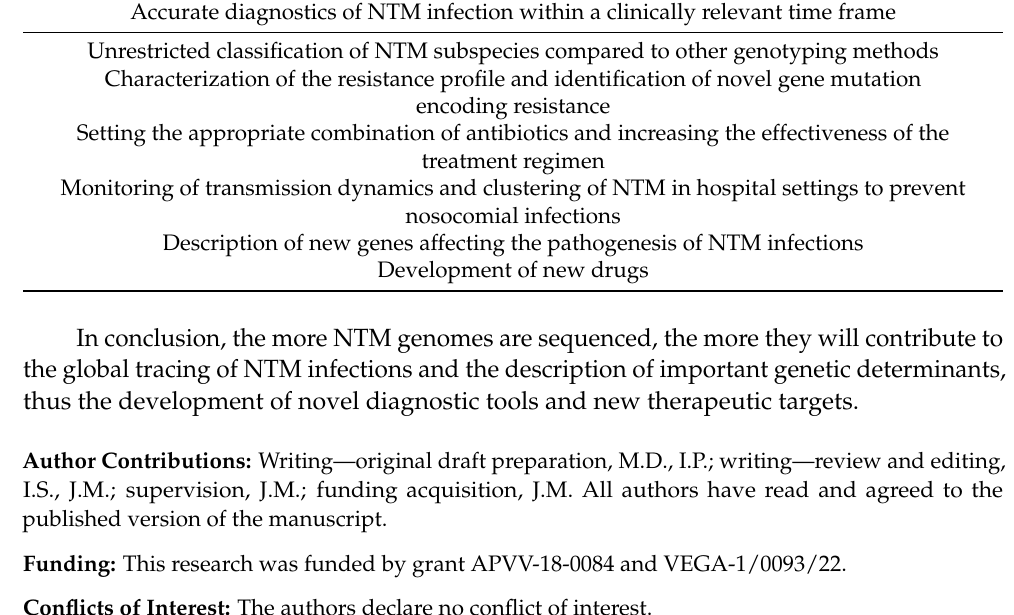
Table 2. Current and potential benefits of WGS in the management of NTM infections. Accurate diagnostics of NTM infection within a clinically relevant time frame Unrestricted classification of NTM subspecies compared to other genotyping methods Characterization of the resistance profile and identification of novel gene mutation encoding resistance Setting the appropriate combination of antibiotics and increasing the effectiveness of the treatment regimen Monitoring of transmission dynamics and clustering of NTM in hospital settings to prevent nosocomial infections Description of new genes affecting the pathogenesis of NTM infections Development of new